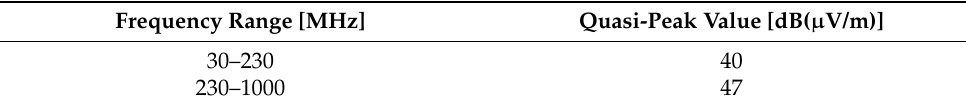
Table 5. Limits allowed for radiated emissions by CISPR 22 (EN 55022).